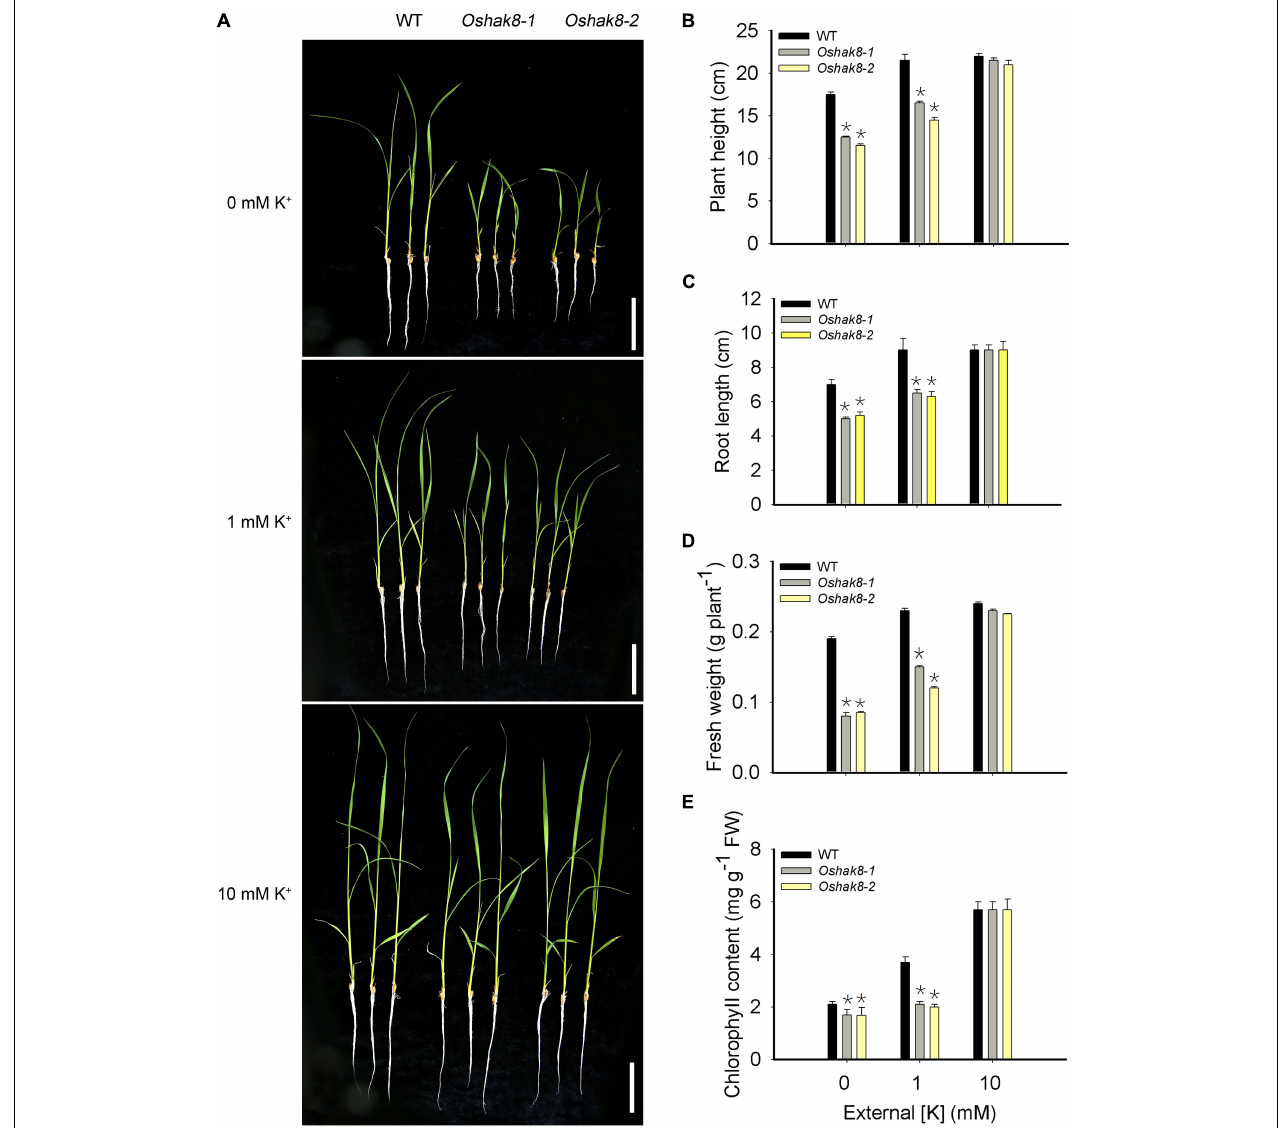
FIGURE 1 | Growth retardation of the Oshak8 mutants under K + -deficient conditions. (A) Growth retardation of the Oshak8 mutants under K + -deficient conditions. The seeds of the wild-type plants (WT) and Oshak8 mutants ( Oshak8-1 , Oshak8-2 ) germinated in water for 5 days, grown in hydroponic solutions containing 0, 1, or 10 mM of K + , and then photographed after 14 days. Oshak8 mutants ( Oshak8-1 , Oshak8-2 ) displayed growth retardation under the K + -deficient conditions. Bars = 4 cm. (B) Plant height of WT and Oshak8 mutants under various K + concentrations. Root lengths of 14-day-old seedlings were measured. Growth conditions were as described in (A) . (C) Root lengths of WT and Oshak8 mutants. Growth conditions were as described in (A) . (D) Fresh weight of WT and Oshak8 mutants. Growth conditions were as described in (A) . (E) Chlorophyll contents of WT and Oshak8 mutants. Growth conditions were as described in (A) . Significant differences were found between WT and Oshak8 knockout plants ( Oshak8-1 , Oshak8-2 ) (* P < 0.01 by Student’s t -test). Data are means of three replicates of one experiment. The experiment was repeated three times with similar results. Error bars represent ± SD. Asterisks represent significant